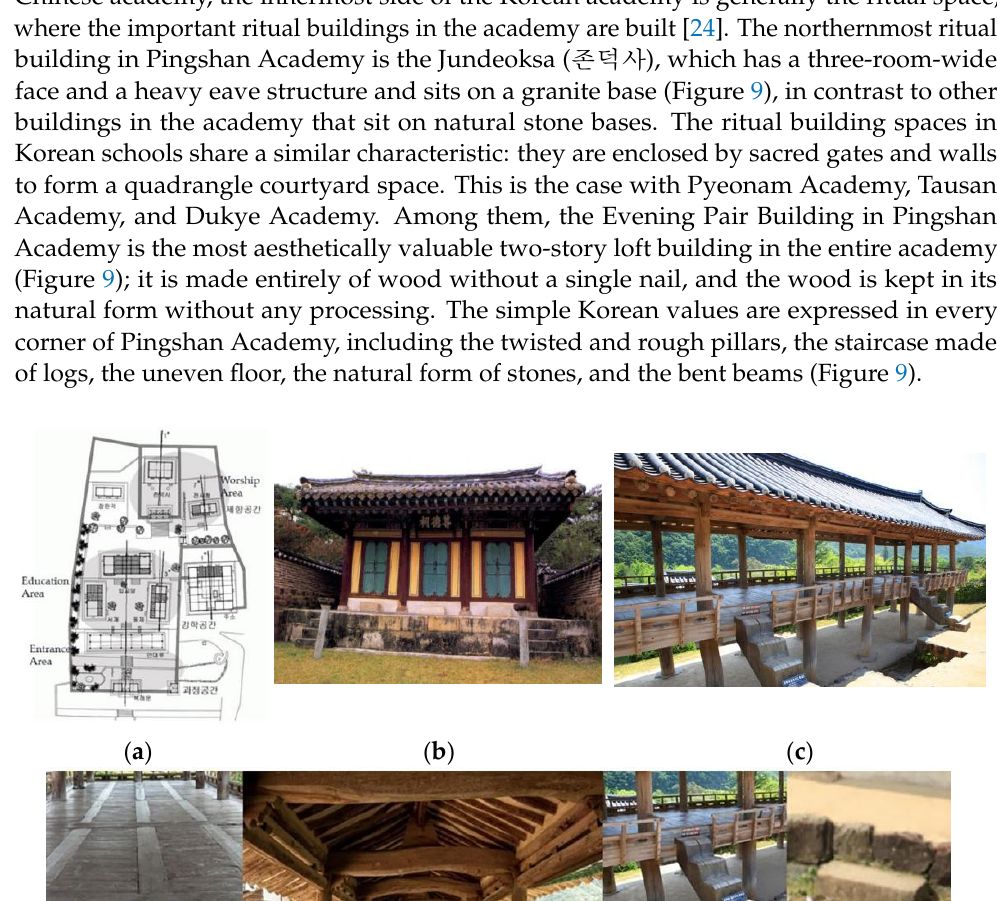
Figure 8. ( a )Axis and Functional Zoning Diagrams of the Yuelu Academy (author’s drawing); ( b ) cross-section of the Middle Axis of Yuelu Academy (source: Architecture and Culture of Yuelu Academy, Yang Shen-chou).